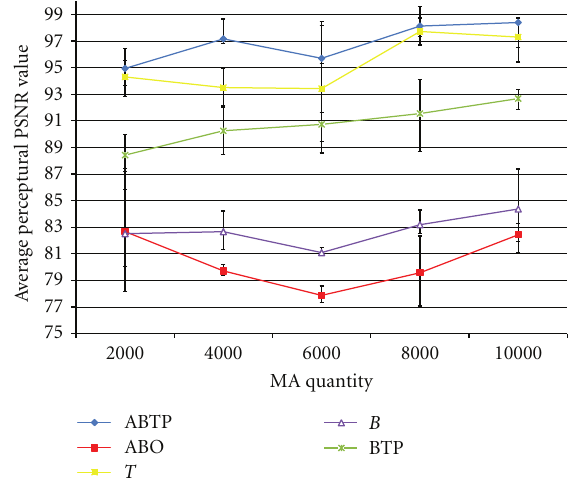
Figure 15: Average perceptual PSNR values on di ff erent MA quantity and optimization